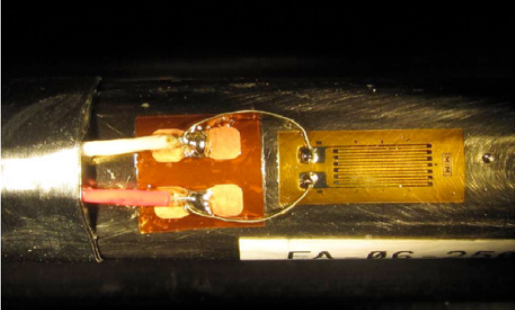
Fig. 6. Connection Tab soldering technique.